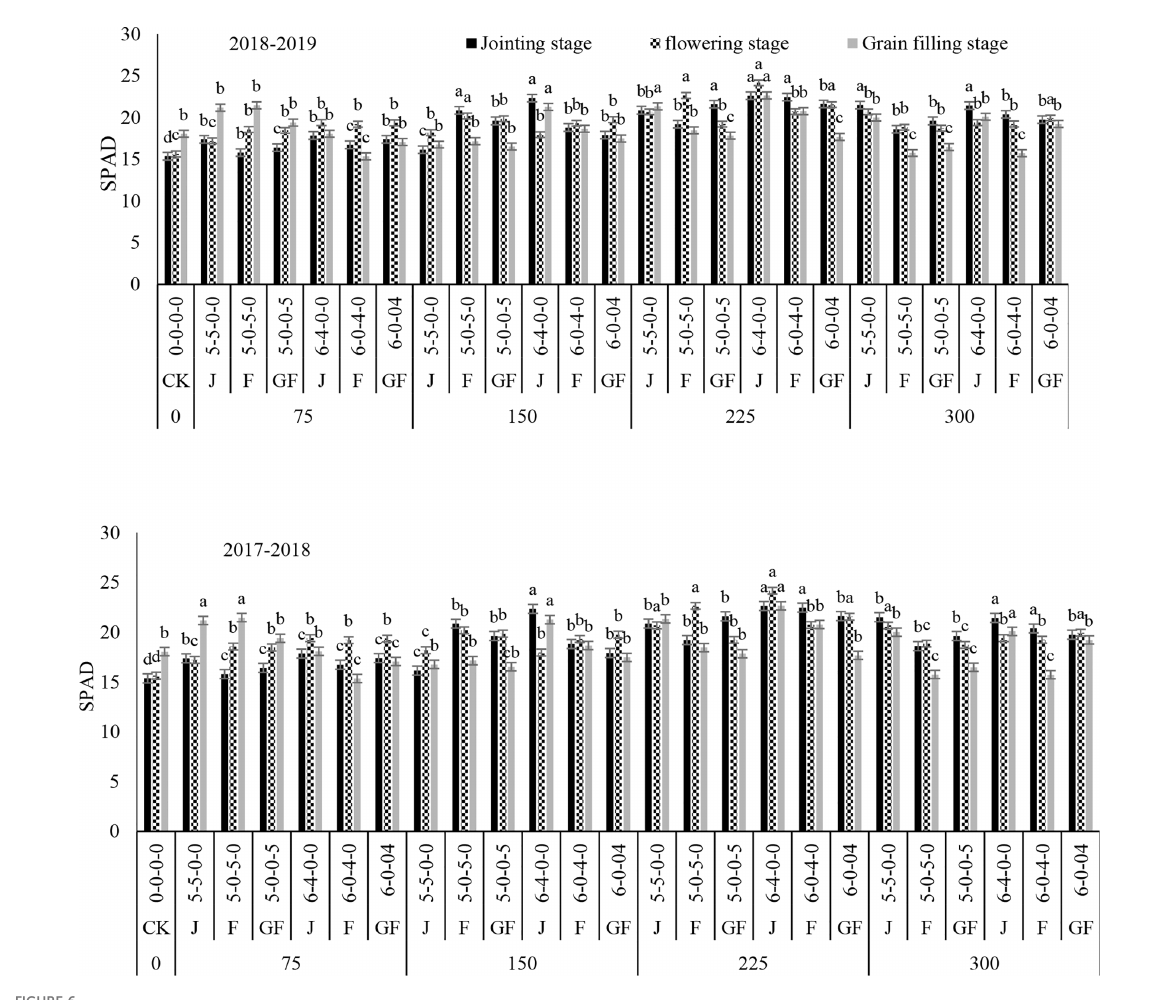
FIGURE 6 Effect of nitrogen fertilizer management on the SPAD 502 of winter wheat. SPAD , soil – plant analysis development; JS , jointing stage; FS , fl owering stage; GF , grain fi lling stage. Different letters in above bars indicate a signi fi cant difference